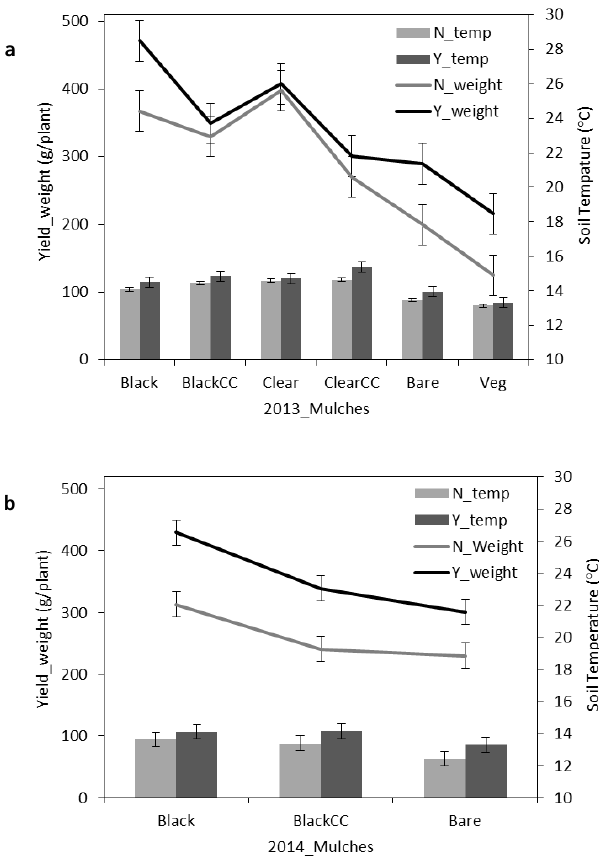
Figure 4. Interactions of mulch and row cover on lettuce yield (weight / plant), and soil temperature (°C) inside high tunnels during the late fall (LF) of 2013 and 2014. ‘ Y ’ represents the mulch with a row cover and ‘ N ’ means the mulch without a row cover.